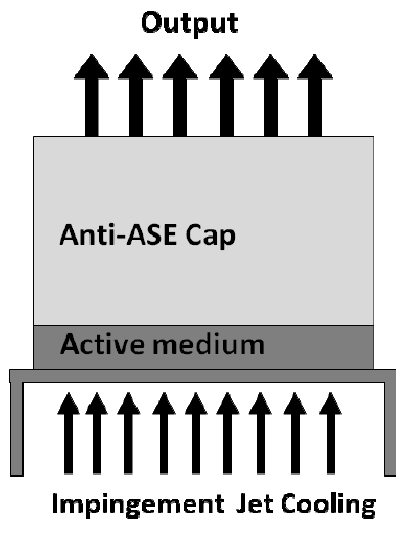
Figure 18. Thin disk laser using a 200 μ m thick 9% Yb:YAG as the active medium and with a 1 mm thick undoped YAG cap (after [39]).